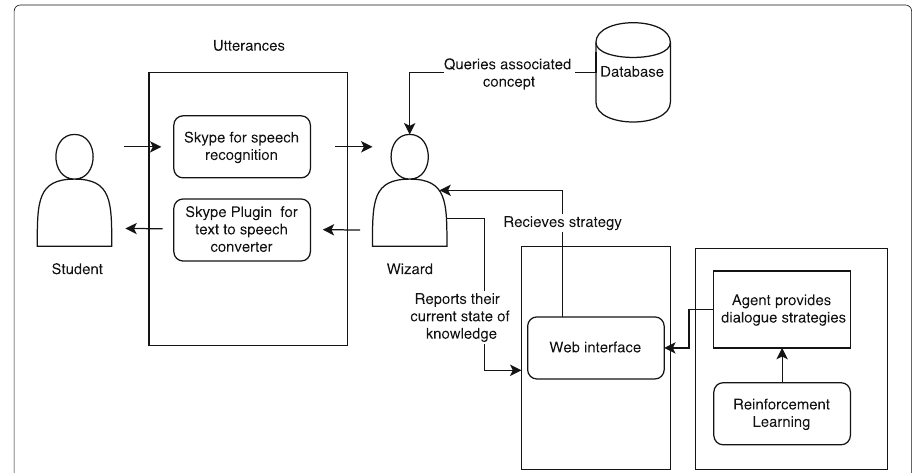
Fig.1 System architecture. Figure 1 shows the system architecture. The student and the wizard communicate through Skype to allow the wizard to see the product the student is asking about. In order to provide the wizard with the optimal dialogue strategy, an agent is trained based on a reinforcement learning algorithm, and passes to the wizard the optimal strategy to take at each step. The wizard reports first their state of knowledge to the agent through a web interface (e.g., I do not have any information about the student’s country yet). Once the agent receives the current state of knowledge of the system, it provides the wizard with the appropriate action to take (e.g., ask for the student’s country). If the agent suggests the querying of the associated concept, the wizard retrieves the CSA from a provided database. The database contains food items as well as their related country of origin, the region of origin, the related ingredients, and their usage. The dialogue, directed by the agent and executed by the wizard, is carried out until the CSA is provided to the student and understood by